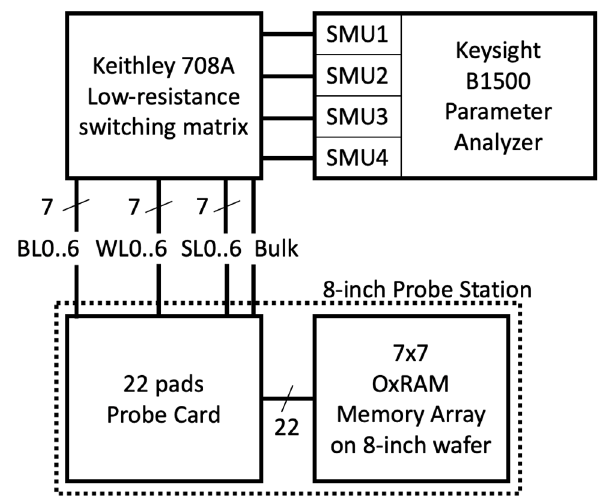
Figure 4. Experimental setup used for the memory array characterization.